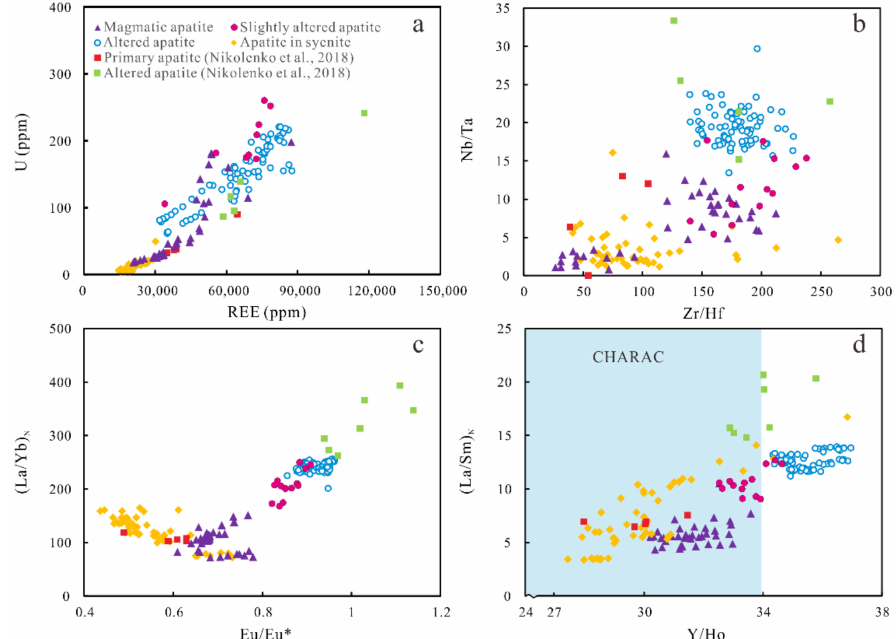
Figure 8. Diagrams displaying trace-element variations of apatite within magnetite-apatite-enriched rocks and syenites from Mushgai Khudag. ( a ) Σ REE versus U; ( b ) Zr/Hf versus Nb/Ta; ( c ) Eu/Eu* versus La/Yb N ; ( d ) Y/Ho versus La/Sm N . The CHArge-and-RAdius-Controlled (CHARAC) interval of Y/Ho ratios in ( d ) was taken from Bau